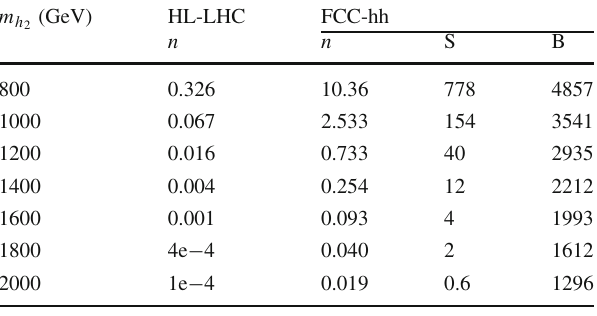
Fig. 13 Significance of the signals calculated as defined in (25) as a function of m h for FCC-hh with an integrated luminosity L int = 2 20 ab − 1 ( a ) and for HL-LHC with an integrated luminosity L int = 3 ab − 1 . The red dashed and red dotted lines indicate upper limits on m h for 3 σ evidence and 5 σ discovery, respectively, for FCC-hh at 2 L int = 20 ab − 1 Table 5 Signal significances for HL-LHC and FCC-hh. For FCC-hh, also event yields are shown